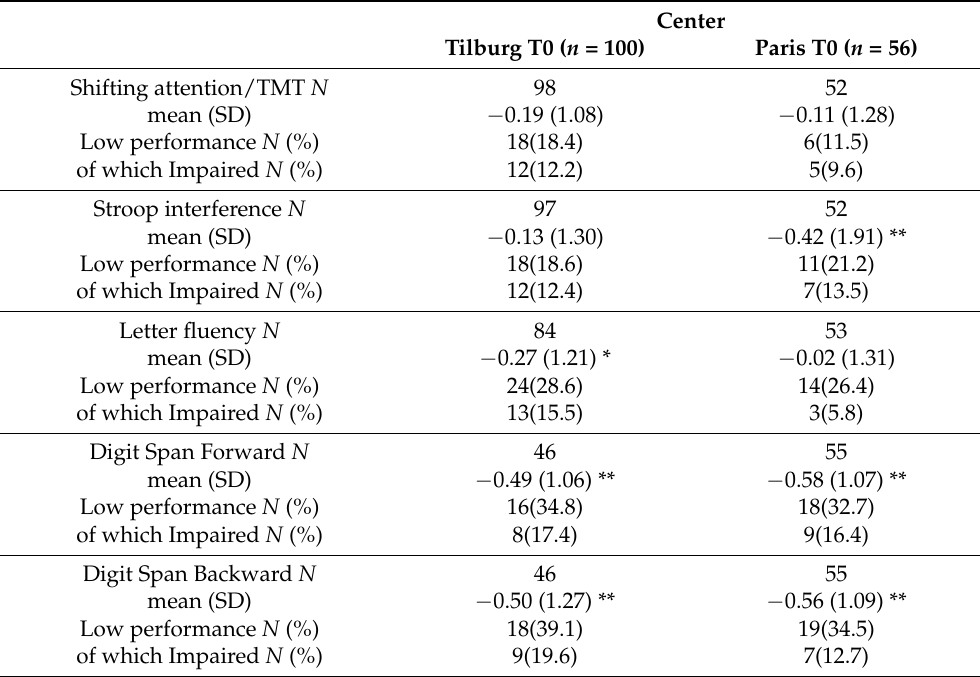
Table 2. Group-level performances on cognitive